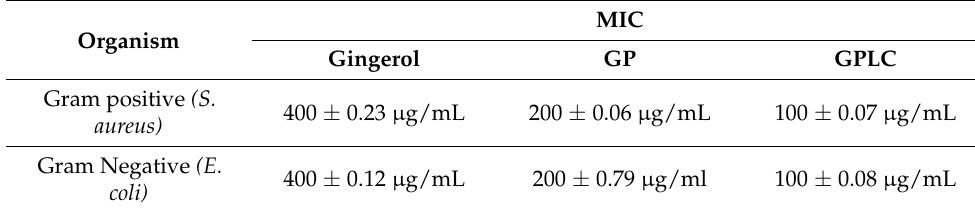
Table 5. In vitro microbial study